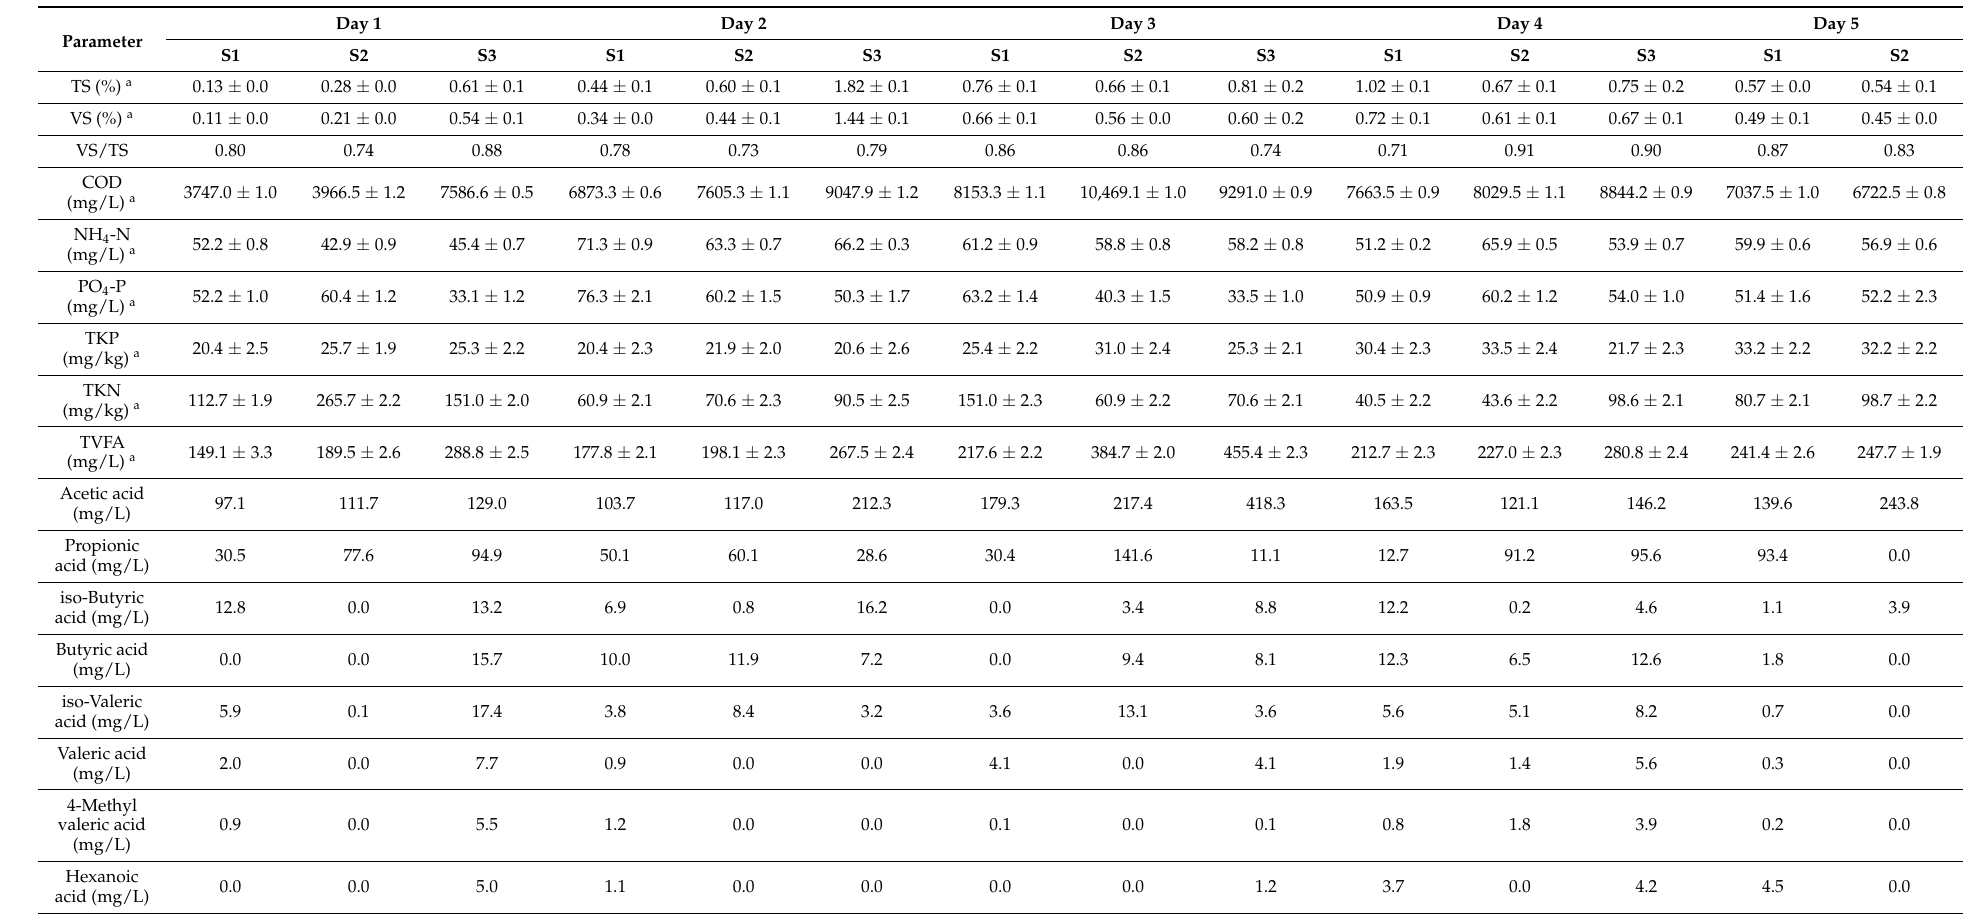
Table 1. Variation in chemical composition of rendering wastewater collected from Monday through